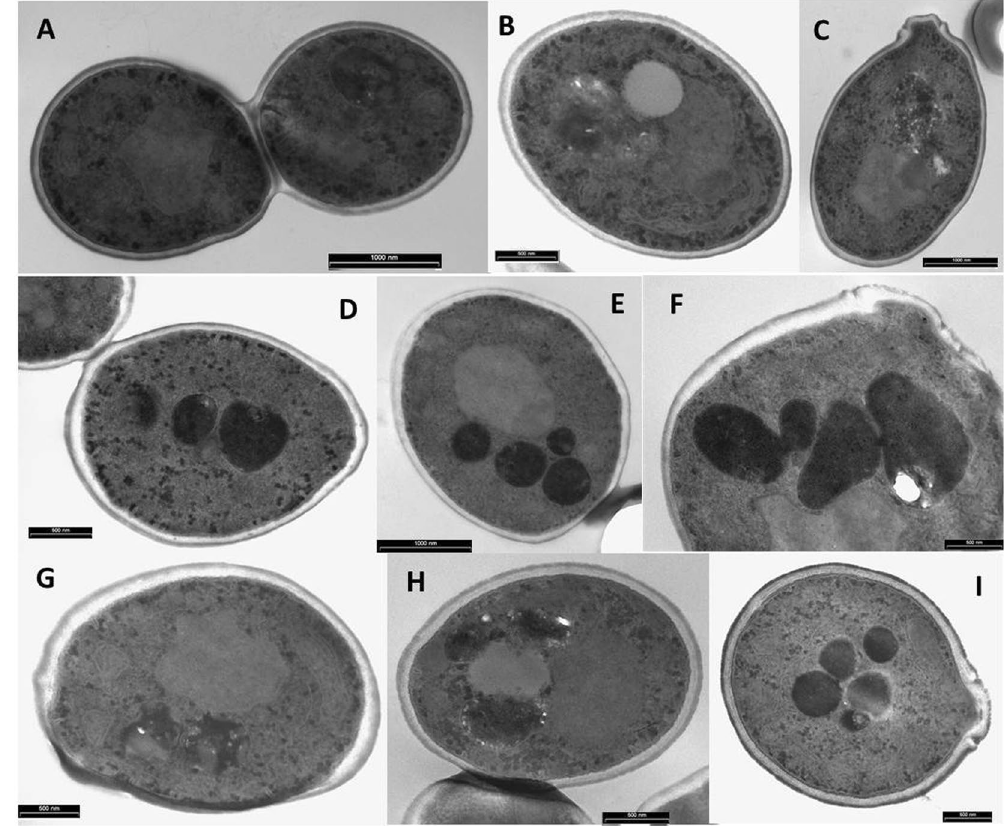
Figure 5. Transmission electron microscopy of Candida albicans cells treated with L12P and L18R peptides. Approximately 10 7 yeast cells were incubated without (panels A–C, controls) or with the selected peptides (125 μ g/ml) (panels D–F, cells treated with peptide L12P; panels G–I, cells treated with peptide L18R) for 60 min. Still intact cells treated with both peptides presented cytoplasmic changes with the presence of a number of microbodies (panels D,E,F,I), membrane retraction and cell wall alteration (panels D,F,G,H). Bar: 1000 nm (panels A,C,E), 500 nm (panels